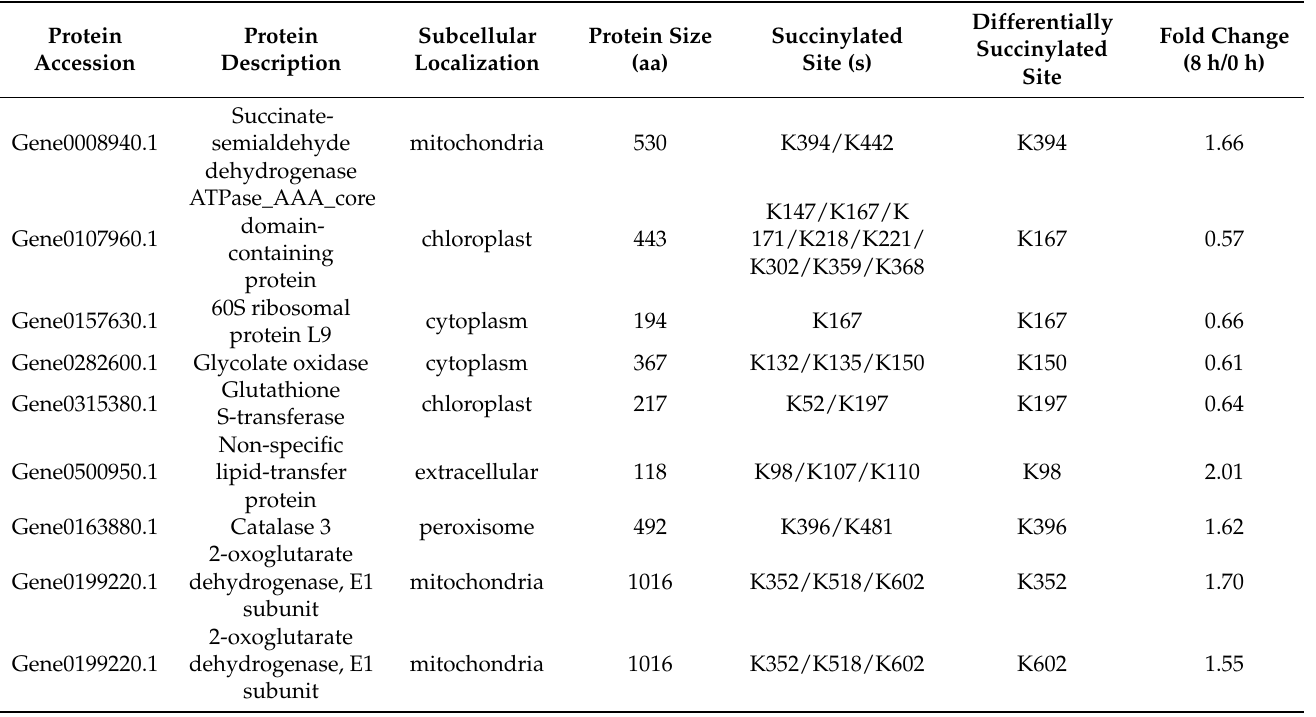
Table 1. Basic information of the differentially succinylated sites identified in the shoots of turnip seedlings in response to Cd